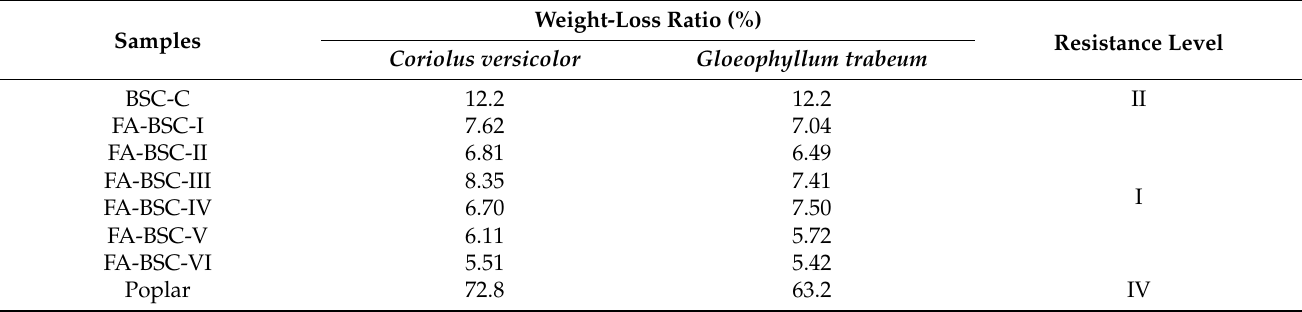
Table 5. Weight-loss ratio of untreated and furfurylated bamboo scrimber after decay-resistance